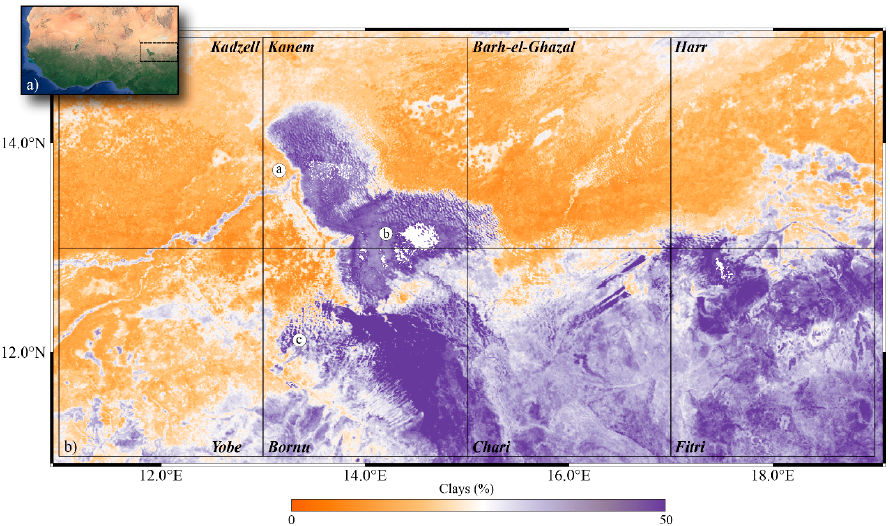
Figure 1. ( a ) Regional context of the studied area (dashed black rectangle). ( b ) GRACE tiles (resolution of each tile is 2° × 2°) superimposed on a map of the clay concentration at the surface of the Lake Chad basin [37]. Tiles have been named after the covered regions or characteristic features (Kadzell, Kanem, Barh-el-Ghazal, Yobe, Bornu, Chari, and Fitri). White dots a-b-c localize the pixels used in Figure 10.